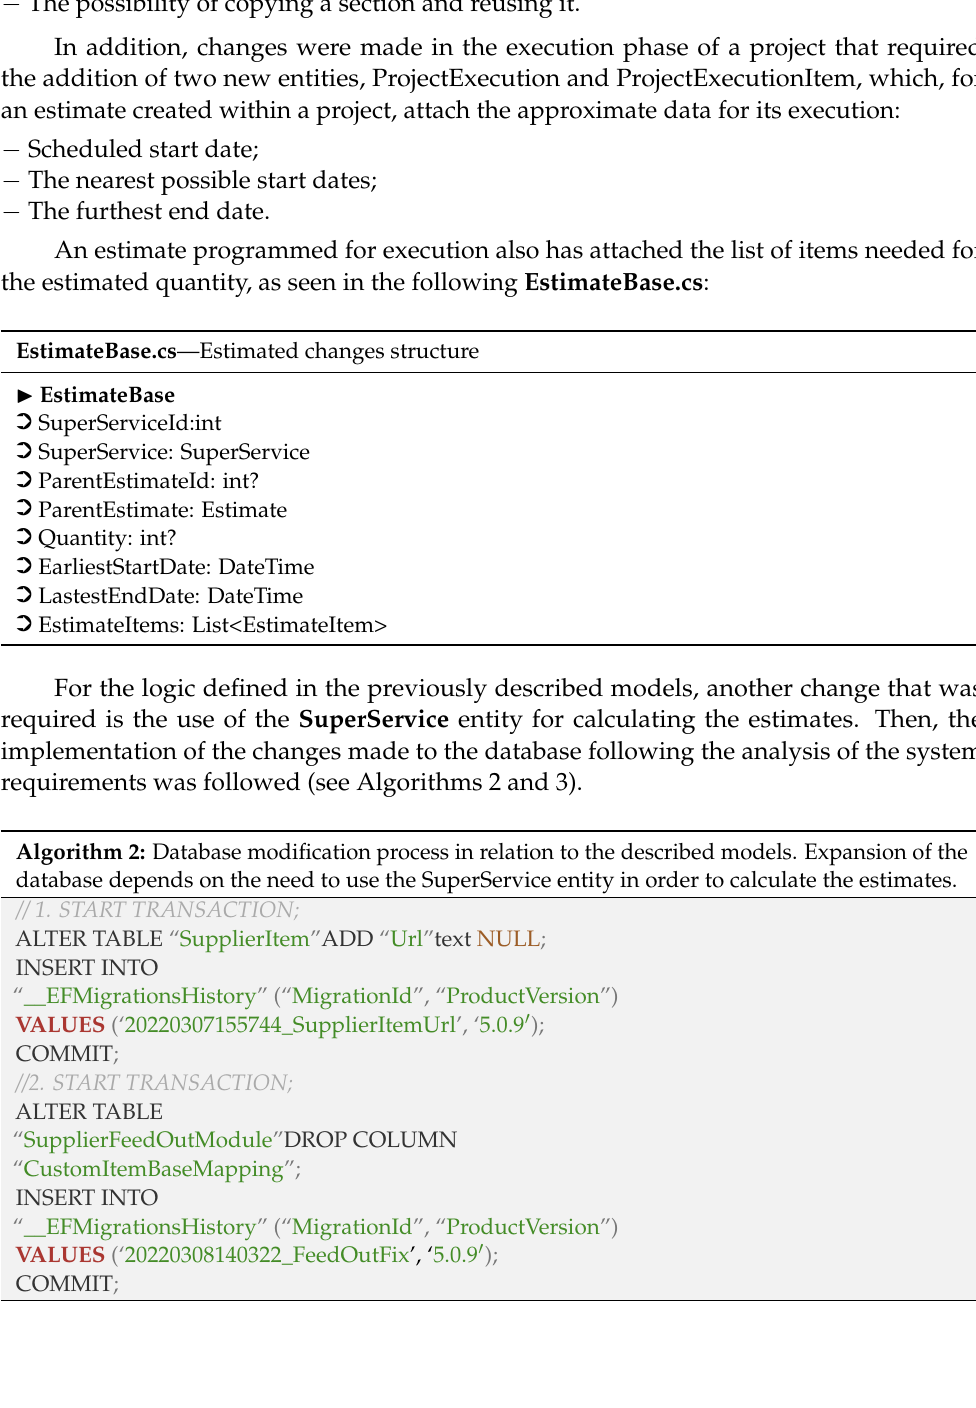
Algorithm 3: Solving problems at the database level and incomplete iterations through Entity Framework mappings.